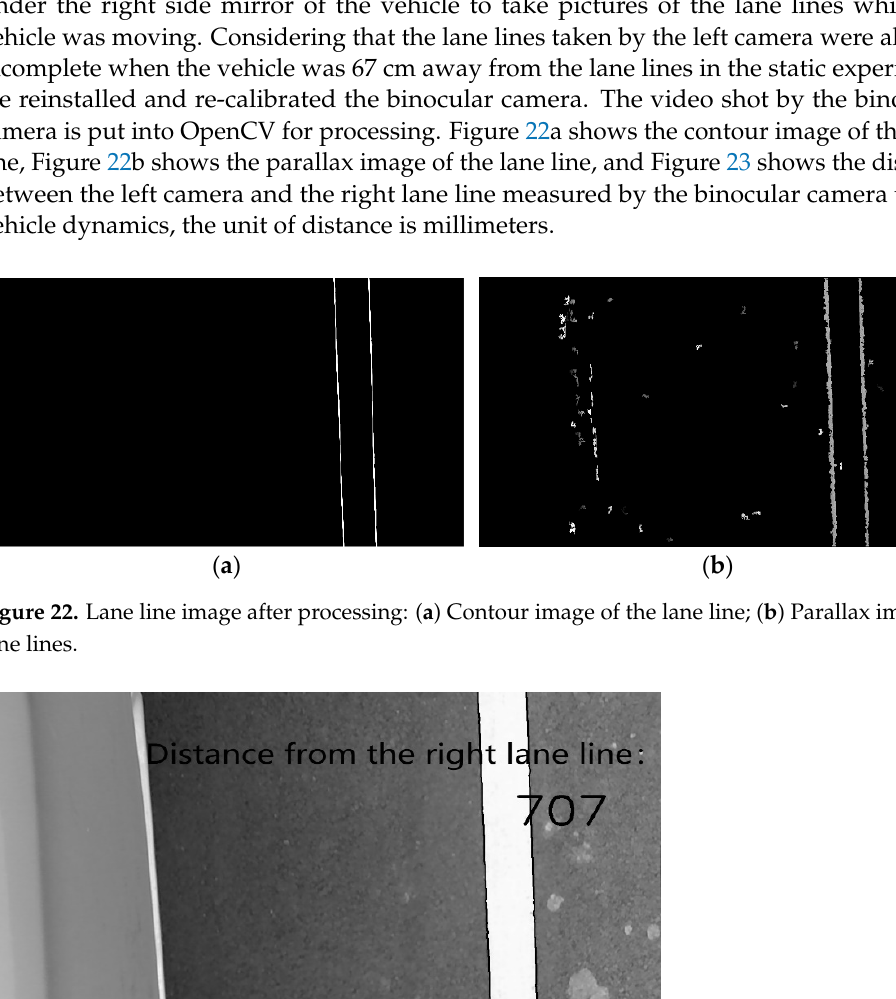
Figure 21. Flow chart of dynamic distance measurement using binocular camera.